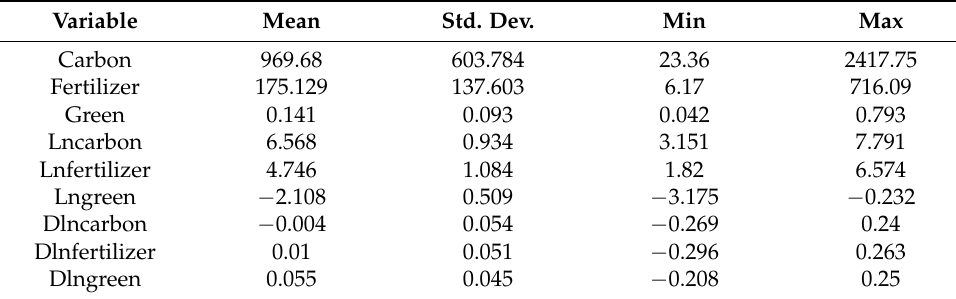
Table 4. The descriptive statistics of the main